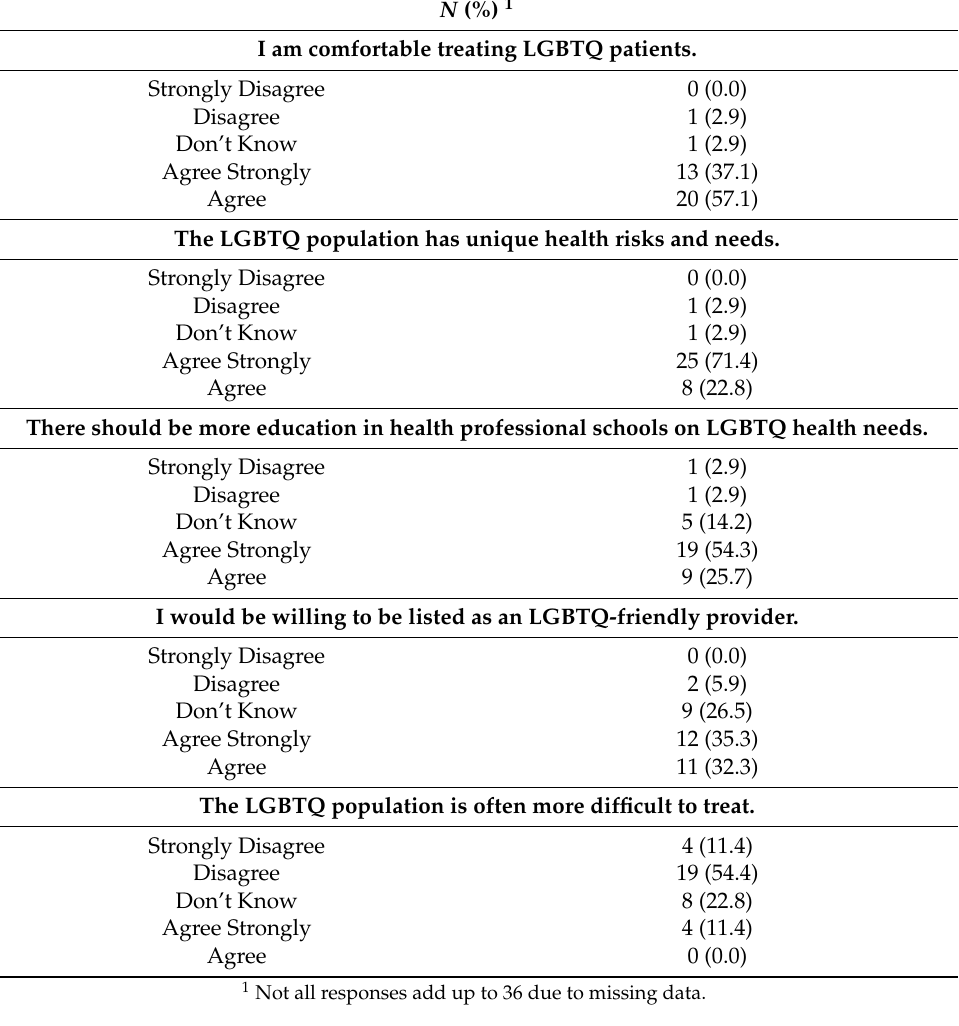
Table 3. Attitudes regarding LGBTQ patients and healthcare among indicated providers ( N = 36). N (%)